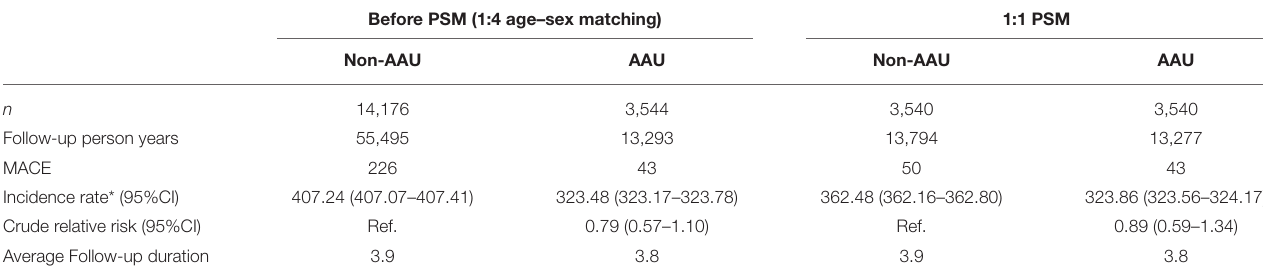
TABLE 2 | Incidence of MACE in PSM study